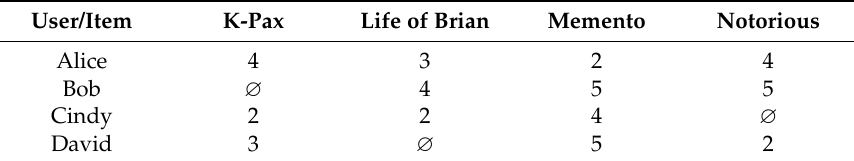
Table 1. An example of a rating matrix